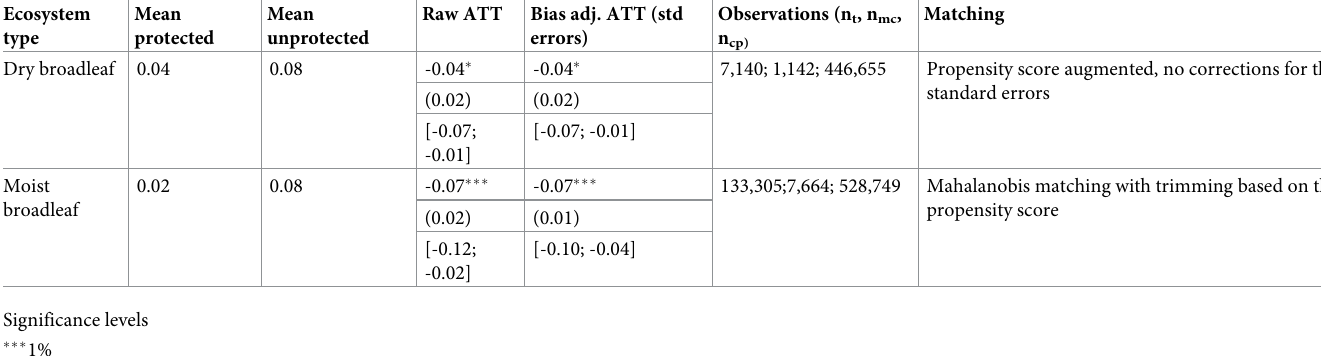
Table 3. Average effectiveness of protected areas by forest type proxied by the average treatment effect on the treated (ATT). The observations falling within pro- tected areas are labeled protected (or treated); the valid matched control - unprotected . The standard errors are given in parentheses and confidence intervals corresponding to each significance level—in square brackets. n t , n mc , n cp indicate treated (on support), matched control, and control pool observations, respectively. A negative sign of the ATT indicates that protection reduced the probability of forest